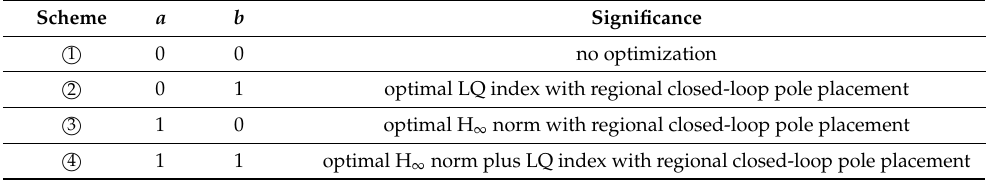
Table 1. Illustration of the different combinations of the coefficients.